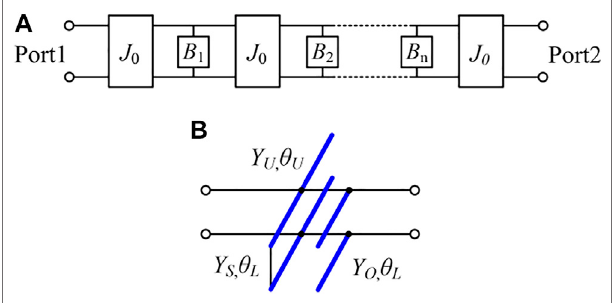
FIGURE 1 | (A) Topology of the classical nth-order dual-band fi lter with dual-band J inverter (B) The adopted dual-band resonator.